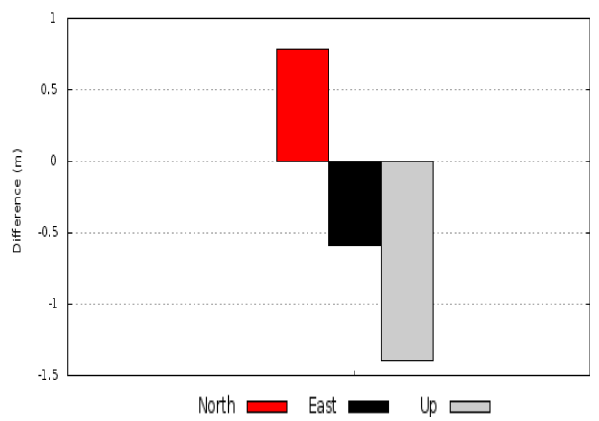
Figure 9: Difference between refined and a priori coordinate for combined (GR) observation processed by magicGNSS software